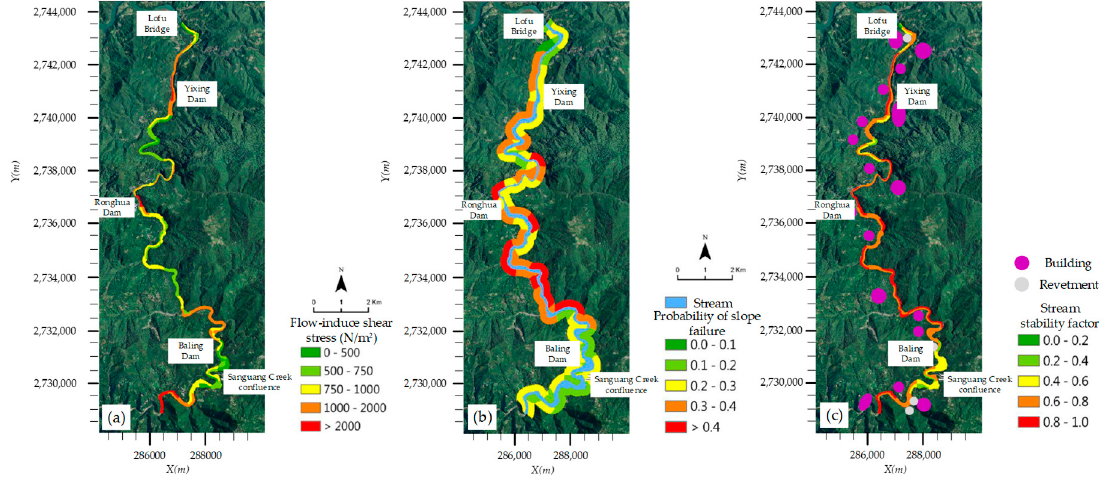
Figure 11. Flow-induced shear stress ( a ), probability of slope failure ( b ), and stream stability factor ( c ) of the study stream for the 200-year return period rainfall.